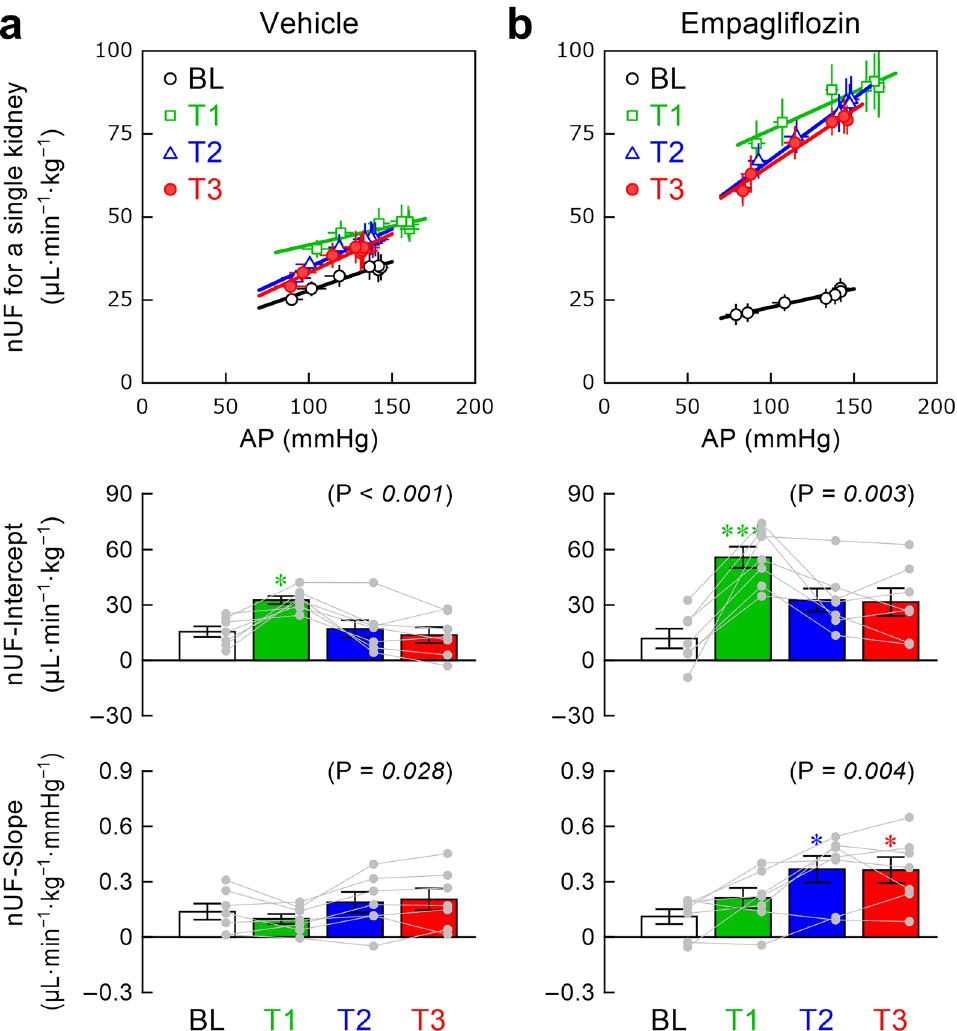
Fig. 5 The relationships of normalized urine flow (nUF) versus arterial pressure (AP) during baseline (BL), T1, T2, and T3 periods obtained in the vehicle ( a ) and empagliflozin ( b ) groups. The top panels show mean SE values with linear regression lines. In the middle panels, nUF-intercept ± indicates the intercept of the AP–nUF relationship. In the bottom panels, nUF-slope indicates the slope of the AP–nUF relationship. For nUF-intercept and nUF-slope, the data are presented as mean SE values with data points of the respective rats (n 7 rats each). In each panel, the ± = P value of the repeated-measures one-way analysis of variance (ANOVA) is shown in the parenthesis. The value is italicized when P < 0.05. Symbols * and *** indicate P < 0.05 and P < 0.001 from BL by the post hoc Dunnett’s